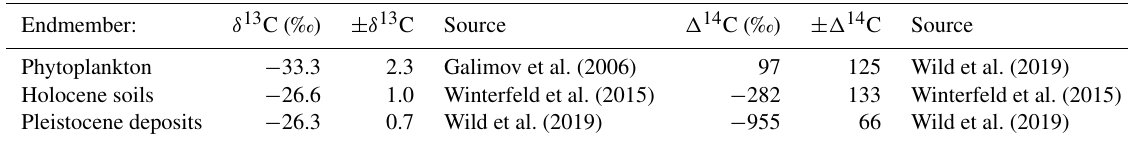
Table 1. Possible sources of C used for the endmember modelling, along with their isotopic composition (after Winterfeld et al., 2015; Wild et al., 2019; Galimov et al., 2006).